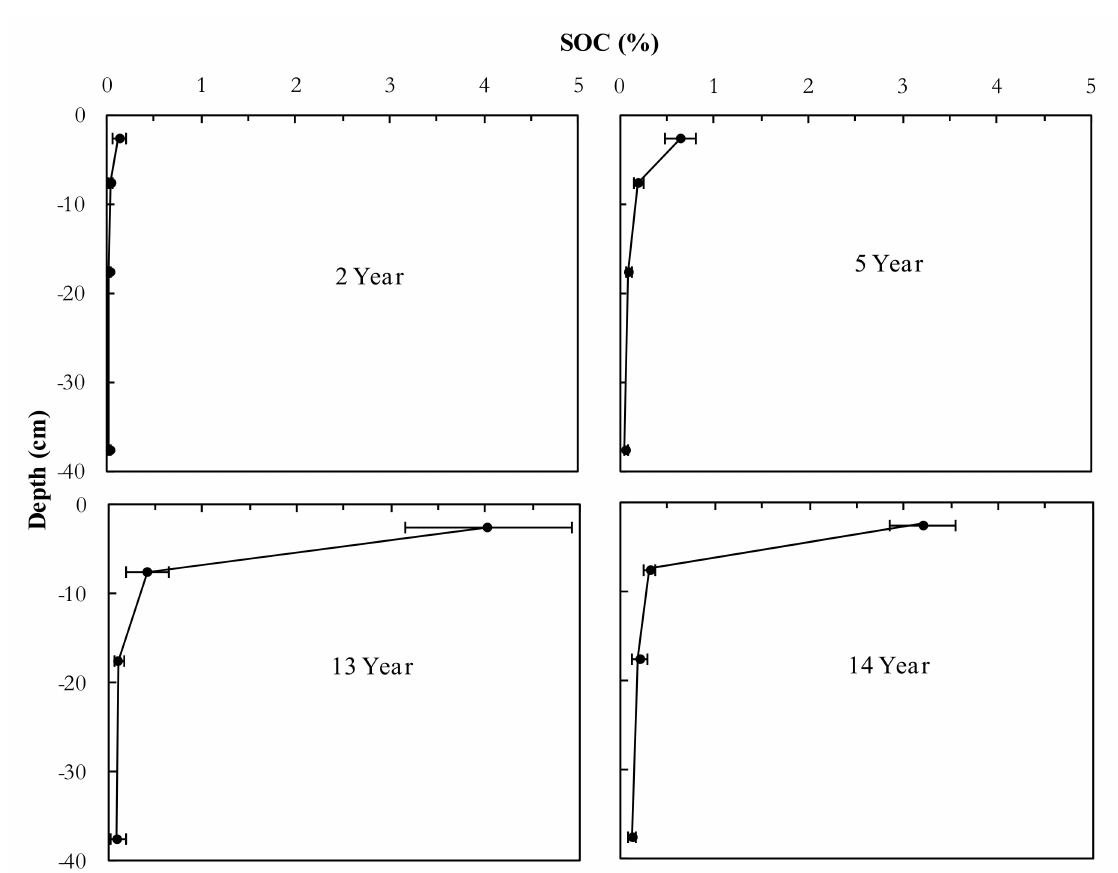
Figure 6. ARRI soil organic carbon (SOC) profiles. Uncertainty reflects ± 1 standard error,